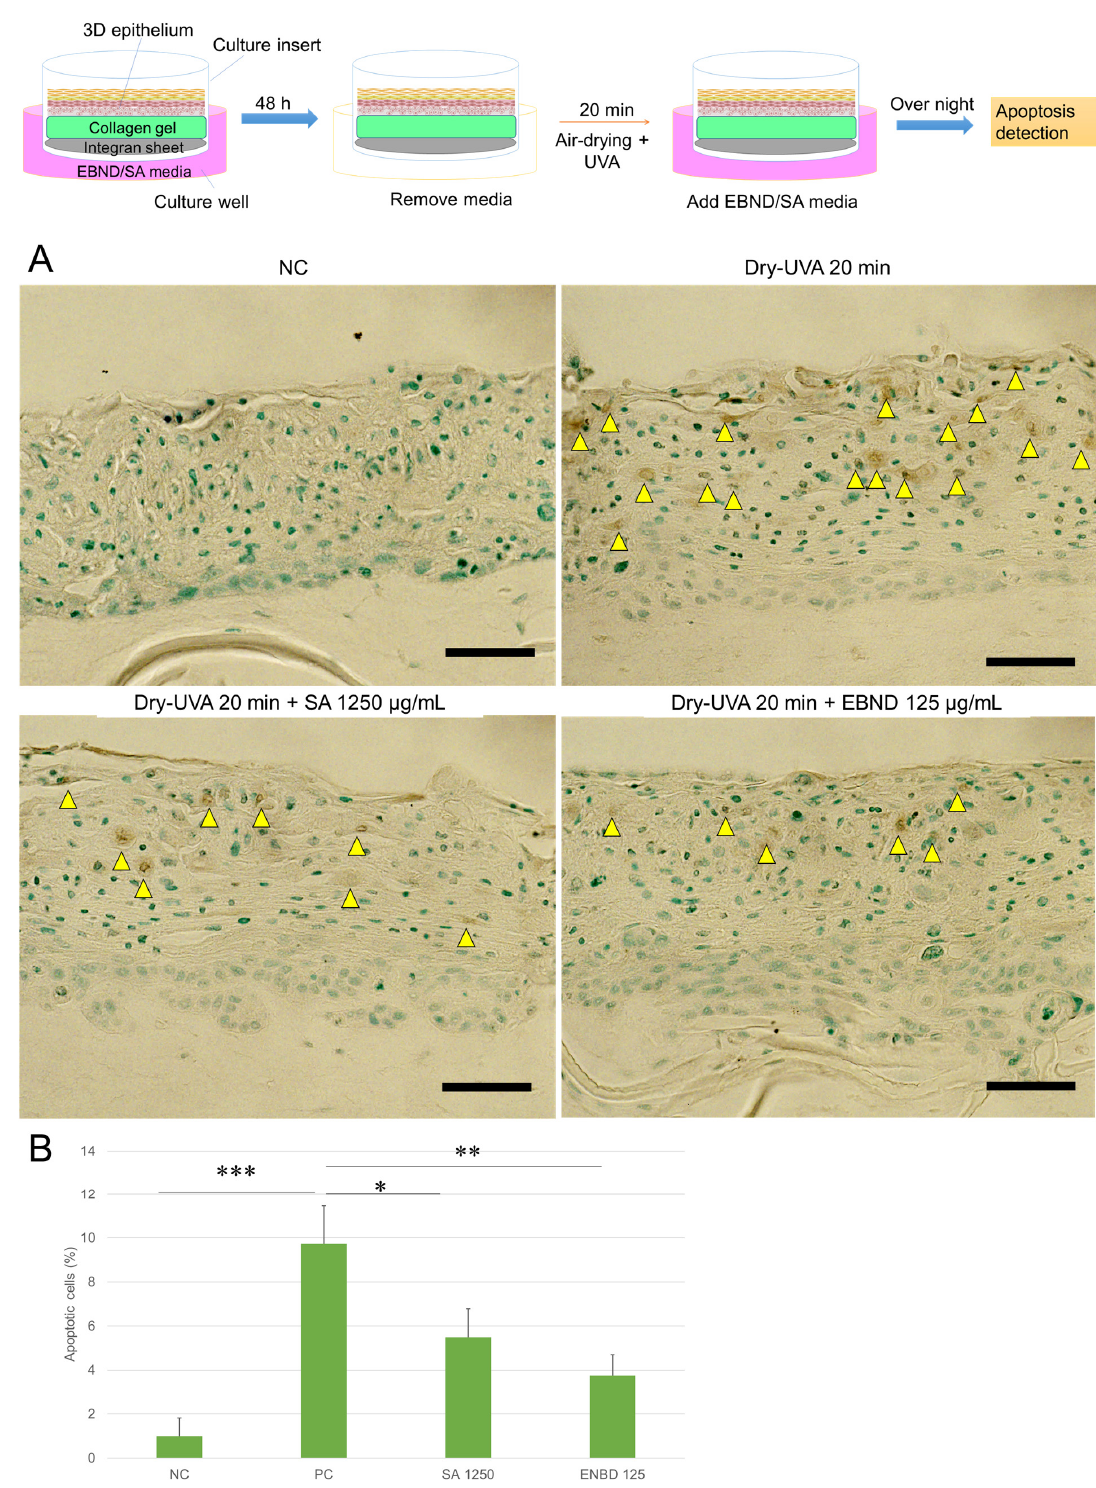
Figure 6. Effects of EBND and SA on Dry-UVA- induced apoptosis in 3D epithelium equivalents. The top illustration represents the experimental procedures. The epitheliums were treated in the same manner as in the description in “Materials and Methods”. At the end of the experiments, apoptotic cells were detected by TUNEL staining. ( A ) Typical images of TUNEL staining. Yellow arrows indicate apoptotic cells. Blue, nuclei. Brown, apoptotic cells. Scale bar = 100 μ m; ( B ) Quantitative analysis of apoptotic cells (analyzed by Image J software). * p < 0.05, ** p < 0.01, *** p < 0.001. Each bar represents the mean ± SD of the three independent